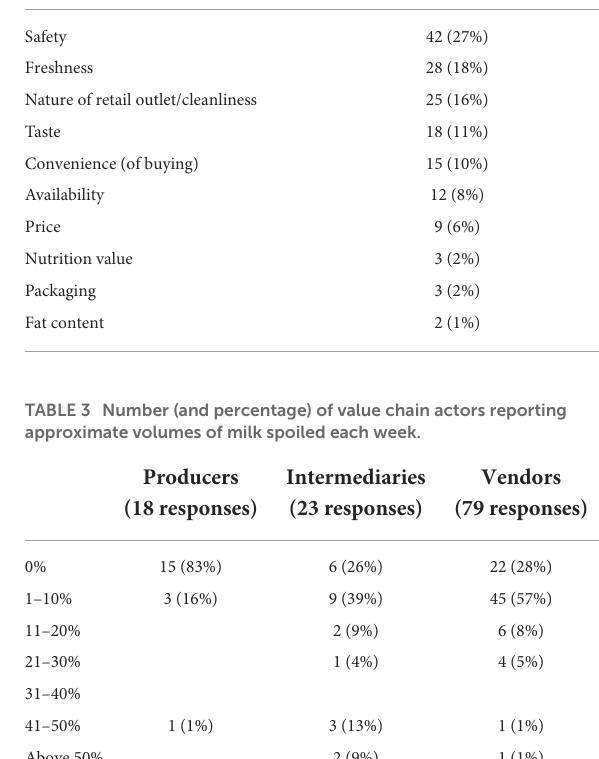
TABLE 2 Most important factors considered by consumers when buying milk (157 responses).